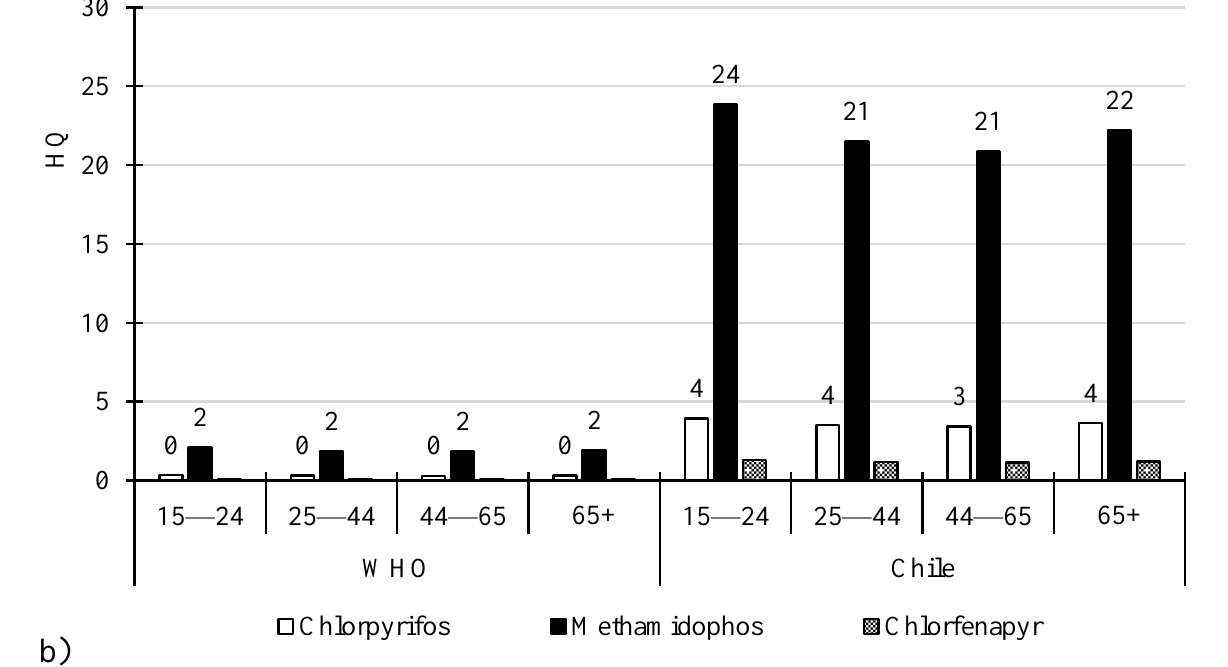
Figure 1. Hazard Quotients (HQ) for all the scenarios in fresh tomatoes from local supermarkets of the Metropolitan Region, Chile: ( a ) Men; ( b ) Woman.